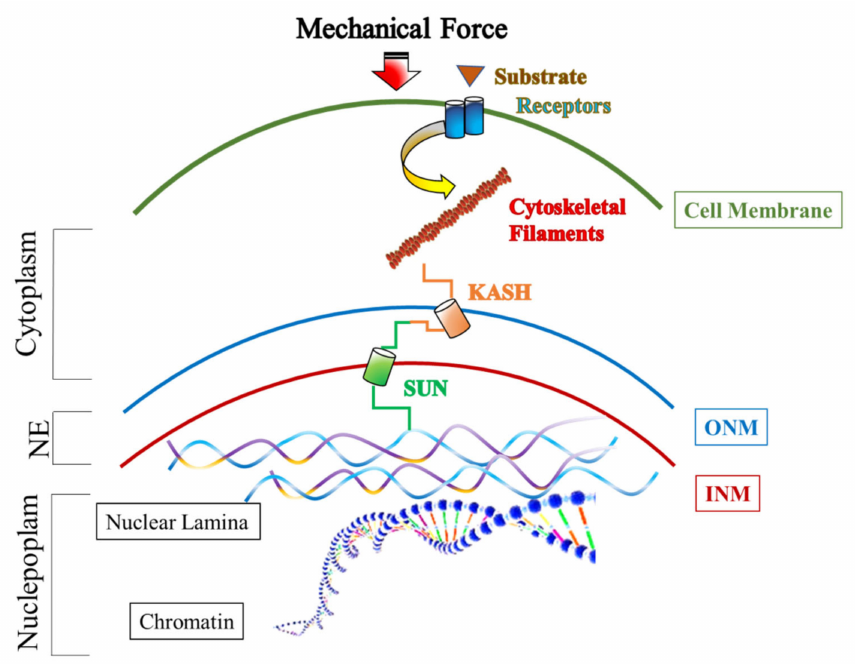
Figure 1. Schematic representation of mechanical force transduction from the cell membrane to the nucleus. Following mechanical stimulus and activation of membrane receptors, a signal transduction pathway is triggered to cytoskeletal filaments that interact with LINC complex components. These last, in turn, interact with nuclear lamina that transmits mechanical force to the chromatin. Finally, chromatin folding changes, induced by mechanical force transduction, modulate gene